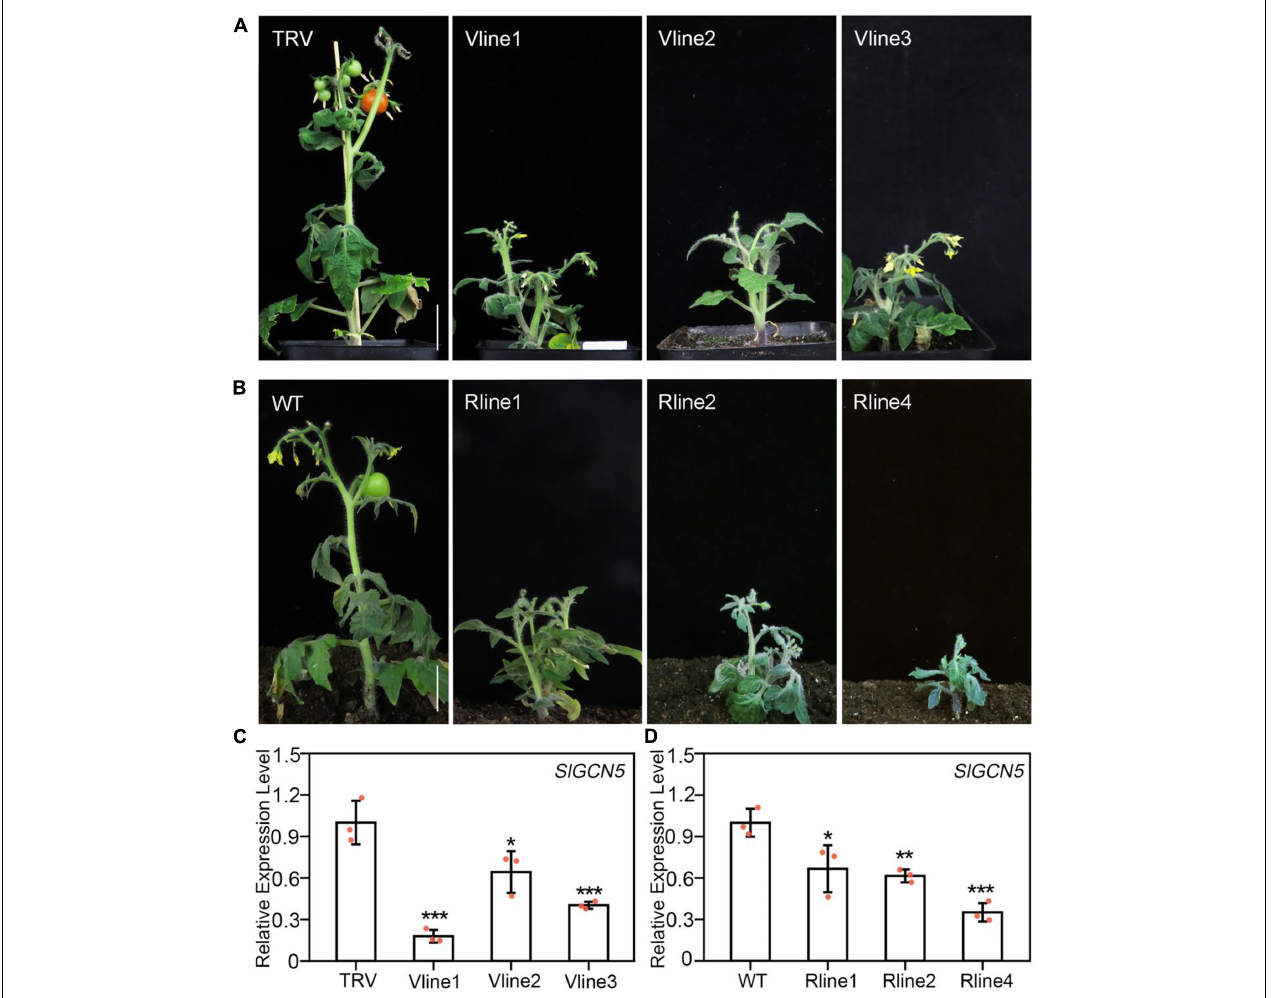
FIGURE 1 | Silencing of SlGCN5 affects plant development. (A) Phenotype of three independent TRV- SlGCN5 lines of Micro-Tom tomato. V lines represent SlGCN5-VIGS lines. (B) Phenotype of three independent SlGCN5 - RNAi lines. (C) qRT-PCR analysis of SlGCN5 transcripts in TRV control and TRV- SlGCN5 plants. (D) Transcript levels of SlGCN5 in SlGCN5 - RNAi lines relative to wild type (WT). Error bars represent SD of three biological replicates. Asterisks indicate significant differences (* p < 0.05, ** p < 0.01, and *** p < 0.001). Scale bars = 3